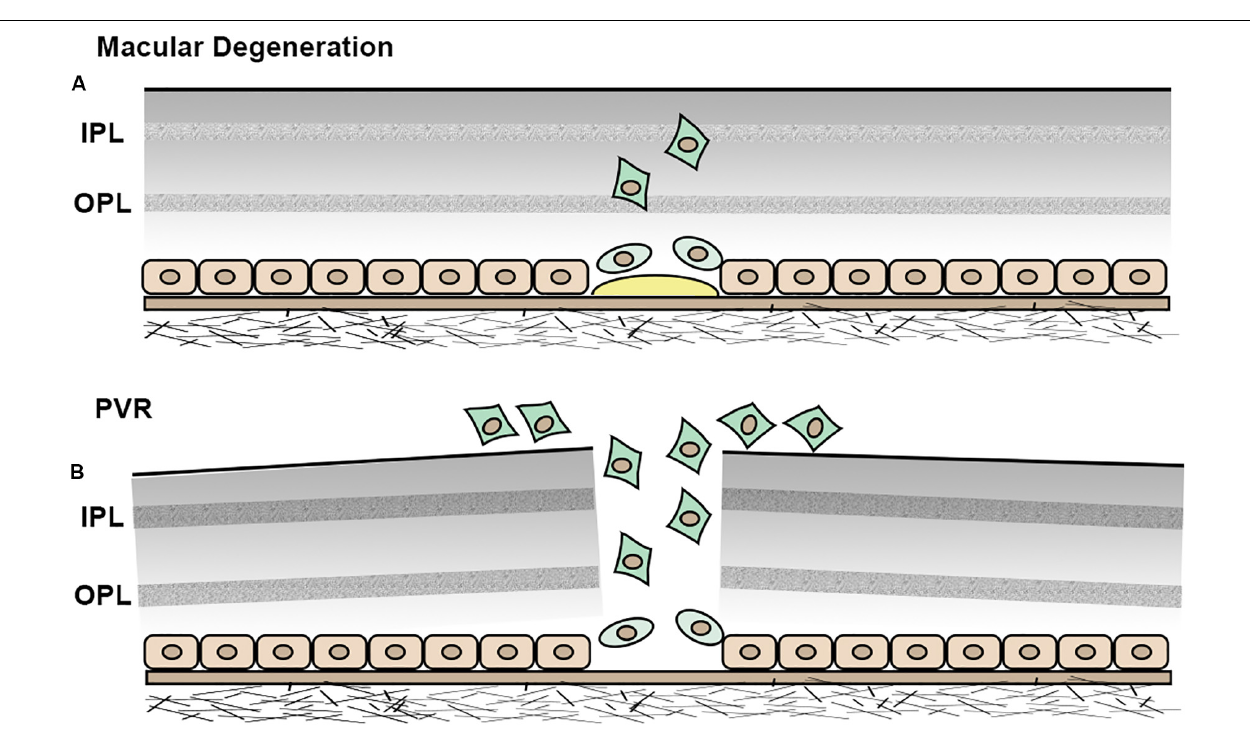
FIGURE 5 | Schematic illustration of EMT in RPE cells. (A) In macular degeneration, RPE cells become less differentiated, undergo EMT and migrate into neuroretina. (B) In PVR, RPE cells undergo EMT and migrate into the epiretinal